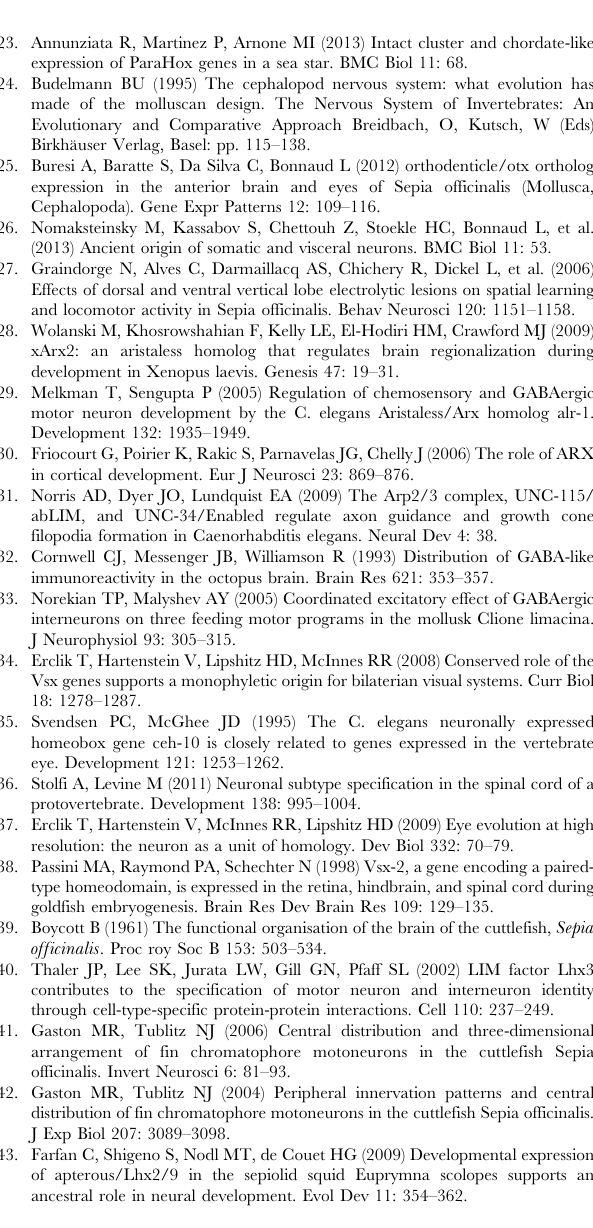
Figure S2 Effect of Adobe Photoshop image manipula- tion used in this work. On the left is an original image taken at the microscope showing the background coloration on a scale from pink to green; on the right is the adjusted image after HIGHPASS Filter with a 250 pixel radius and adjustment of brightness and contrast. The background colouration results in an even grey scale after this procedure. Circles represent the areas where background colour was sampled from both images. (TIFF) Supporting Information S1 Homeodomain multiple se- quence alignment. a) CLUSTAL O (1.2.0) multiple sequence alignment used for phylogenetic analysis. Sequences recovered in the current study are highlighted in boldface type.